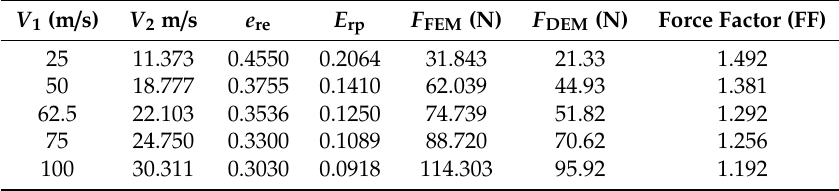
Table 4. Elastic-plastic Run Shot 0.3556